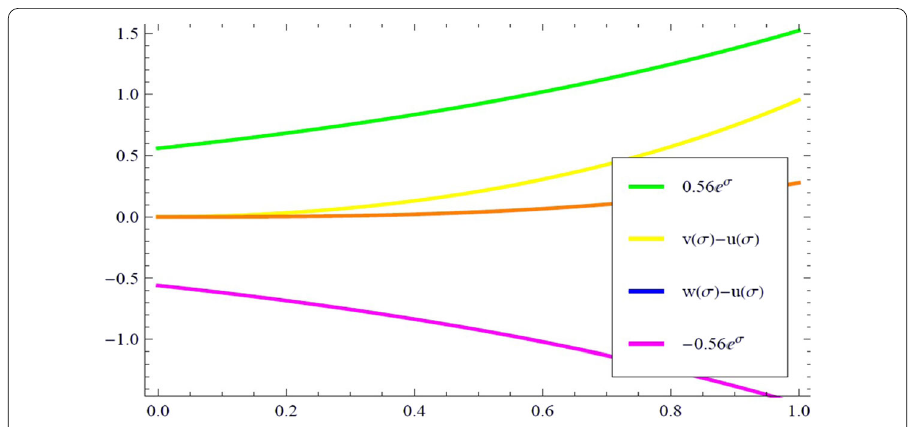
Figure 3 Functions v ( σ ) – u ( σ ), w ( σ ) – u ( σ ), and ± 0.56 e